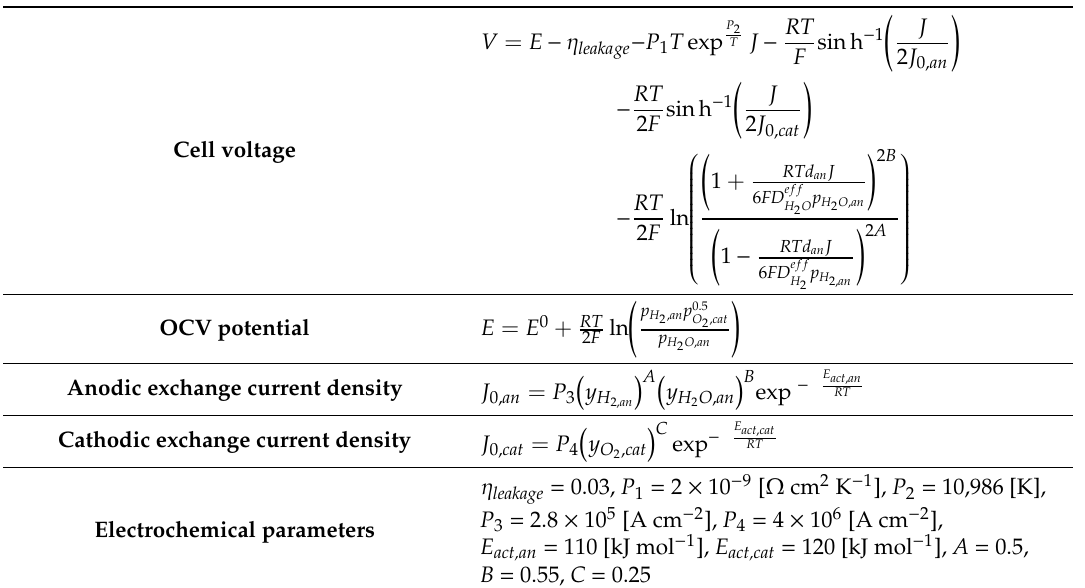
Table 2. Solid oxide fuel cell (SOFC) electrochemical kinetics (for the complete description refer to